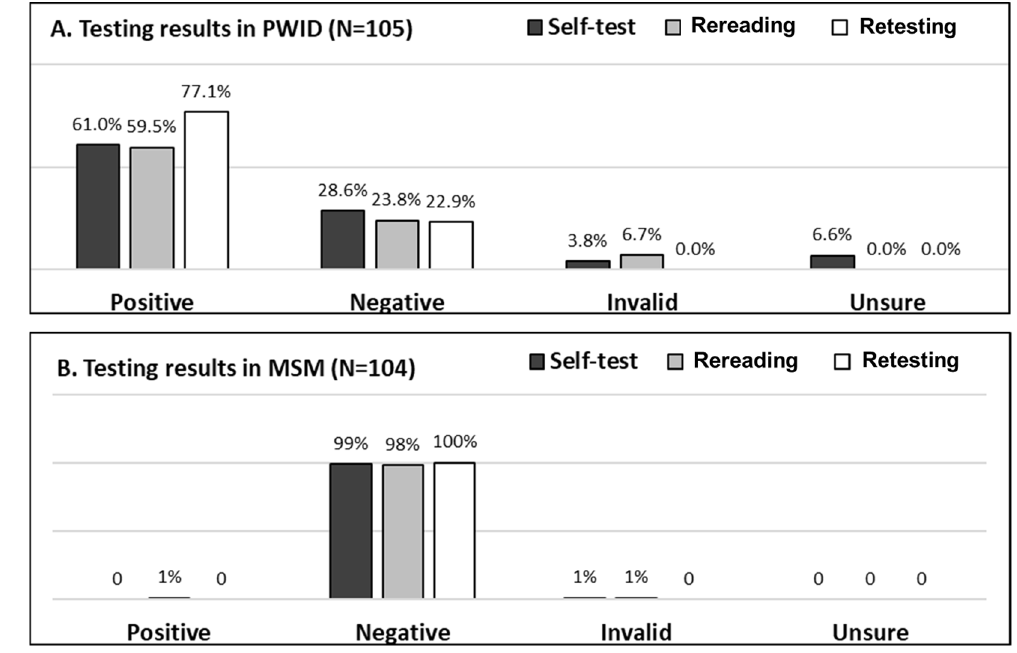
Figure 2. Summary of HCV testing results in PWID ( A ) and MSM ( B ) for participant self-testing, rereading by trained staff, and retesting performed by trained staff. Table 5. The concordance of HCV testing results performed by the participants (self-testing), re-interpreted by the health care staff (rereading) and performed by the study staff (retesting) in PWID and MSM. PWID ( n